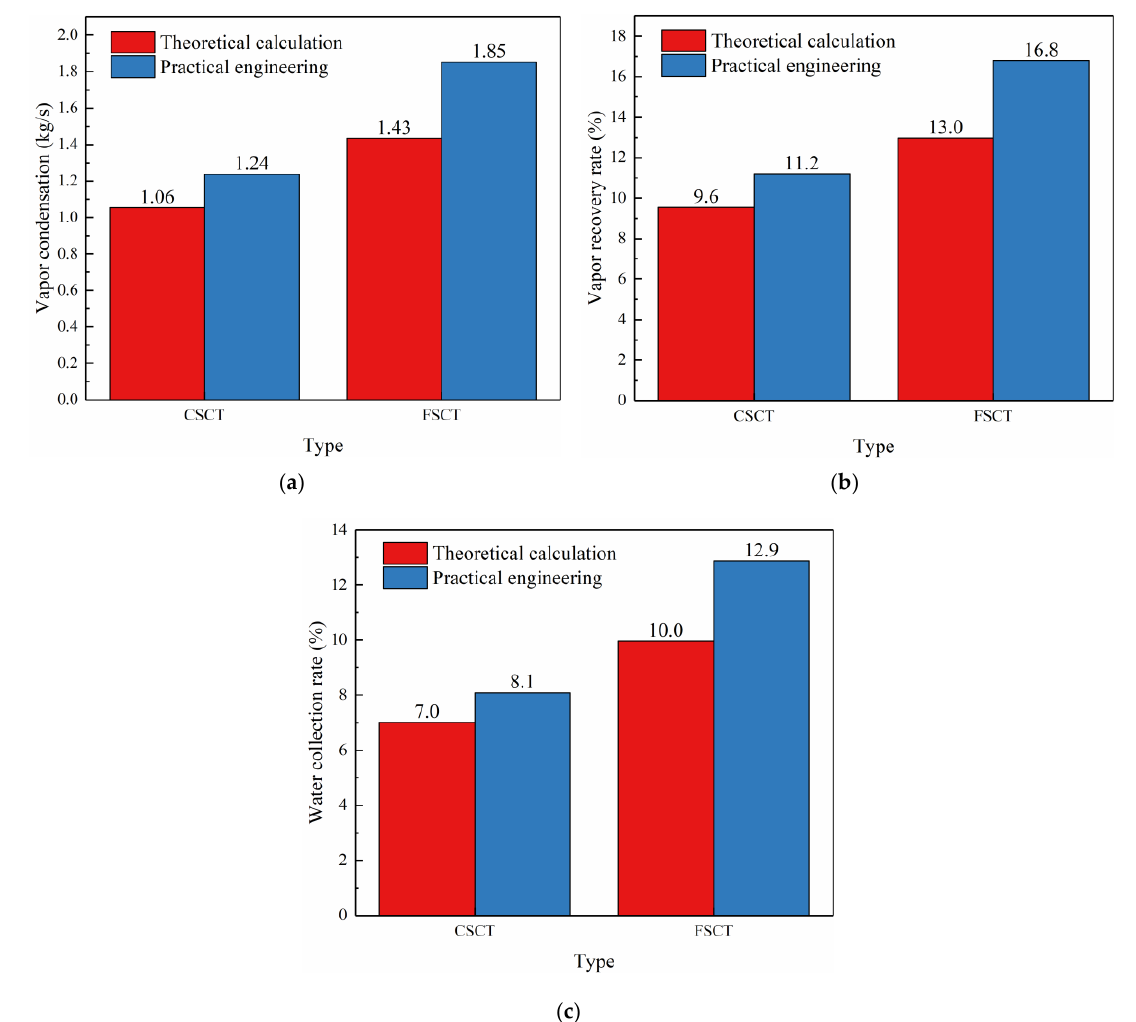
Figure 10. Comparison between theoretical calculation and practical engineering. ( a ) Vapor Figure10. Comparisonbetweentheoreticalcalculationandpracticalengineering. ( a )Vaporcondensation, condensation, ( b ) Vapor recovery rate, ( c ) Water collection. ( b ) Vapor recovery rate, ( c ) Water